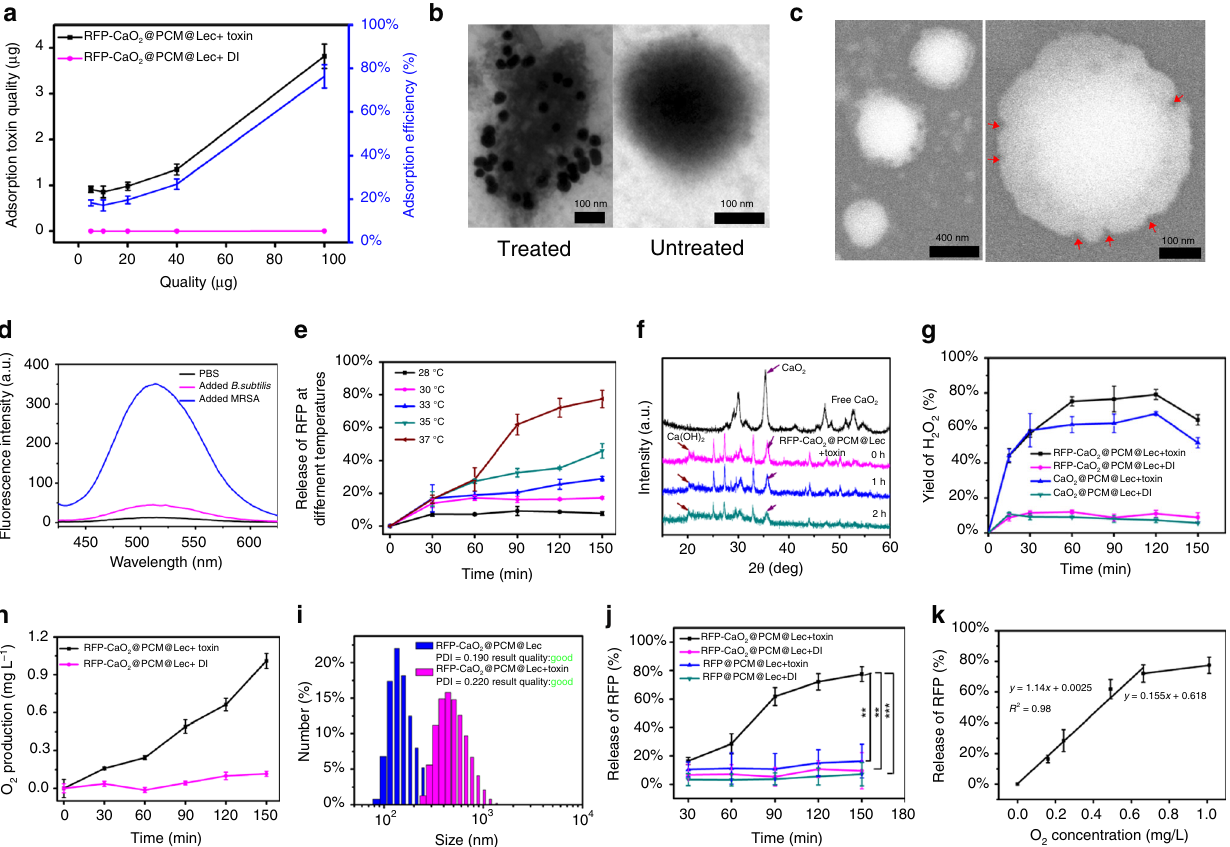
Fig. 2 Endogenous stimulus-triggered drug release from the nanoreactors. a The RFP-CaO 2 @PCM@Lec nanoreactors-captured toxin assay. b Transmission electron microscopy (TEM) images of nano-toxin immunostained with rabbit anti-toxin as the primary antibody and gold-labeled anti-rabbit IgG as the secondary antibody. c SEM images of toxin forming pore. d The fl uorescence of ANTS recovered owing to the release of the ANTS under the in fl uence of MRSA (blue), B. sublitis (red),and PBS buffer (black). e The RFP release from the RFP-CaO 2 @PCM@Lec nanoreactors and RFP@PCM@Lec incubated with toxin and DI water at different temperatures (28, 30, 33, 35, 37 °C) and different periods of time (30, 60, 90, 120, 150 min). f Characterization of Ca(OH) 2 formation by XRD. g Ratio of H 2 O 2 production to theoretical yield at different time points (15, 30, 60, 90, 120, 180, 360, 540, 720 min). h O 2 production at 37 °C at different time points (30, 60, 90, 120, 150 min). i The size changes after toxin was anchored into RFP-CaO 2 @PCM@Lec nanoreactors. j The RFP release from the RFP-CaO 2 @PCM@Lec nanoreactors and RFP@PCM@Lec incubated with toxin and DI water at 37 °C for different periods of time (30, 60, 90, 120, 150 min). k The correlation between gas generation and drug release. Error bars = standard deviation ( n = 3). Source data are provided as